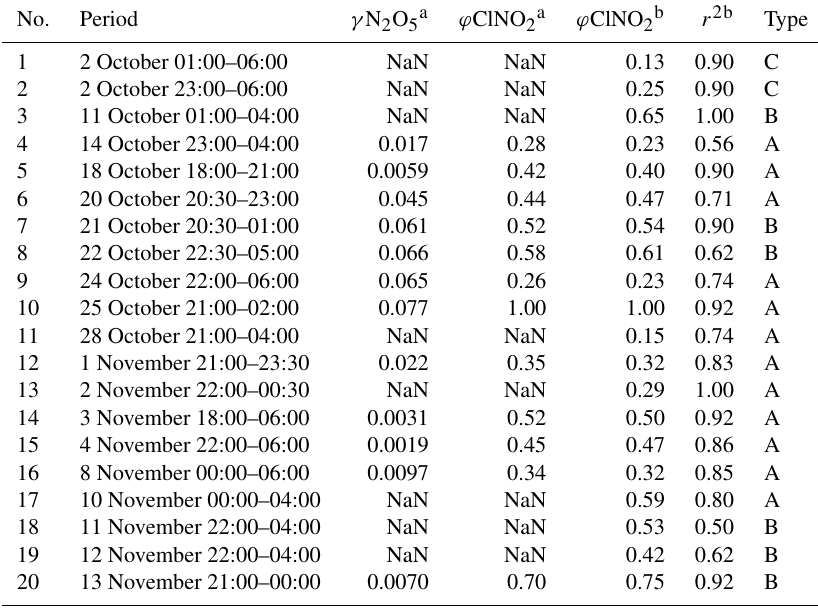
Table 4. The derived N 2 O 5 uptake coefficient and ClNO 2 yields at each night. NaN means not a number. No. Period γ N 2 O 5a ϕ ClNO 2a